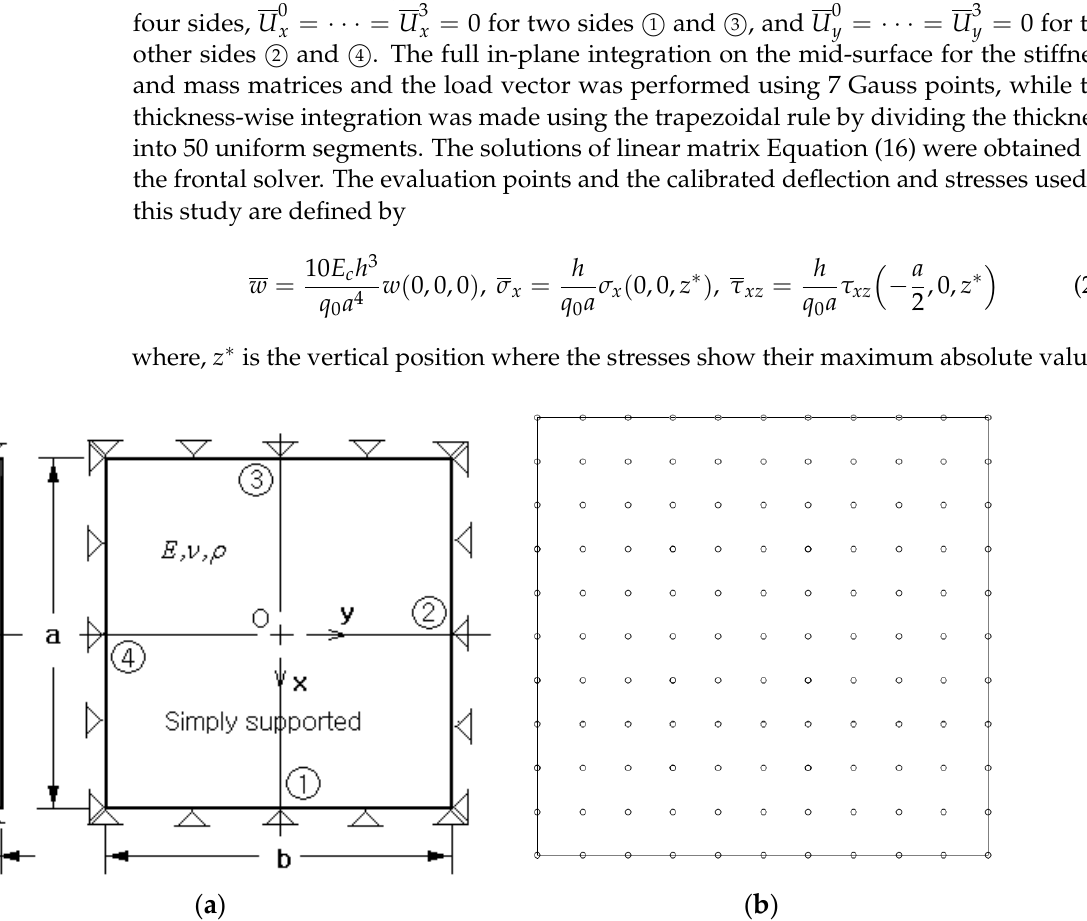
Figure 3. ( a ) A square FG porous plate under the uniform vertical distributed load q 0 , ( b ) an 11 × 11 uniform NEM grid.